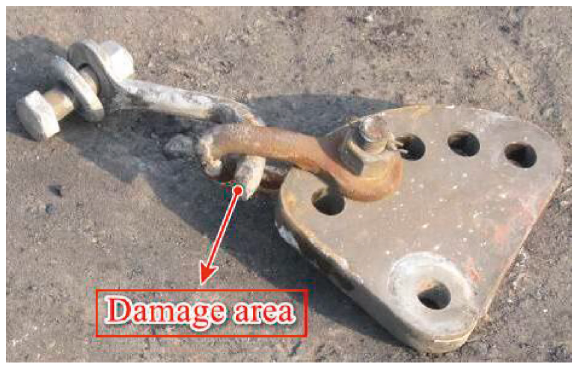
Figure 33: The fracture mode of the